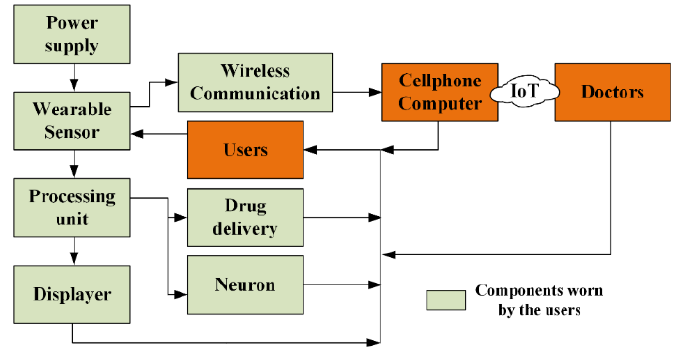
Figure 13. The ideal composition of wearable health monitoring system.